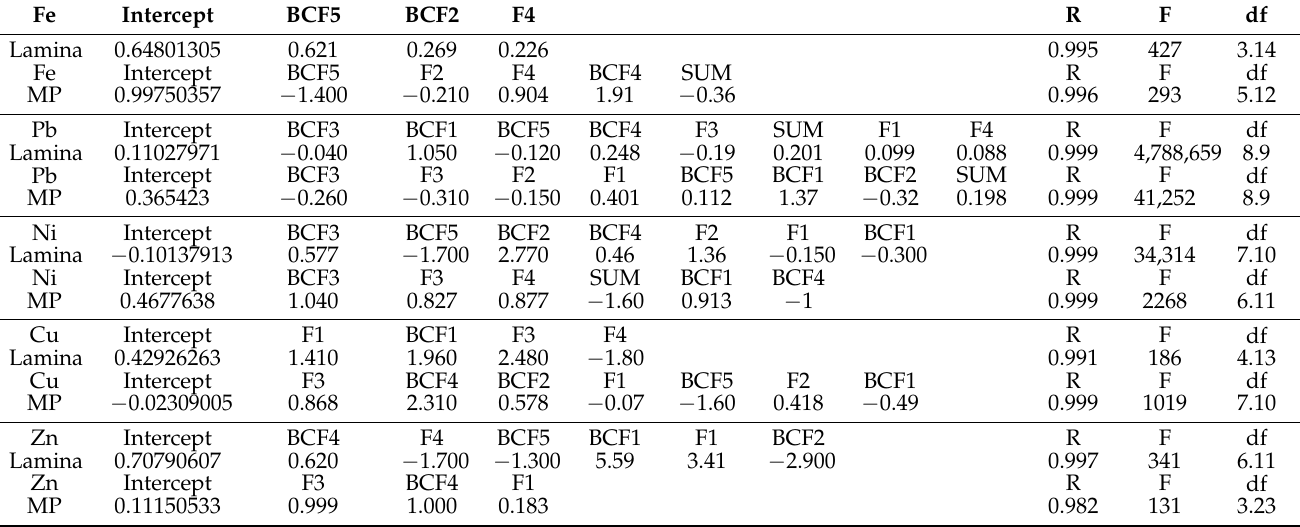
Table 9. Multiple linear stepwise regression analytical outputs based on Avicennia leaves (lamina (L); midrib plus petiole (M)) as dependent variables and independent variables are the bioconcentration factors and sedimentary geochemical